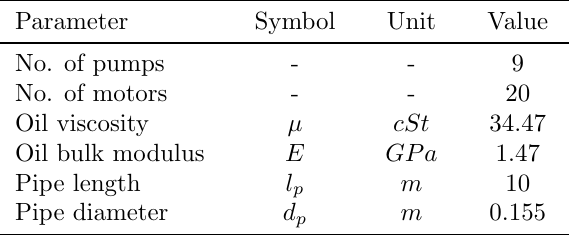
Table 3: General hydraulic drive parameters